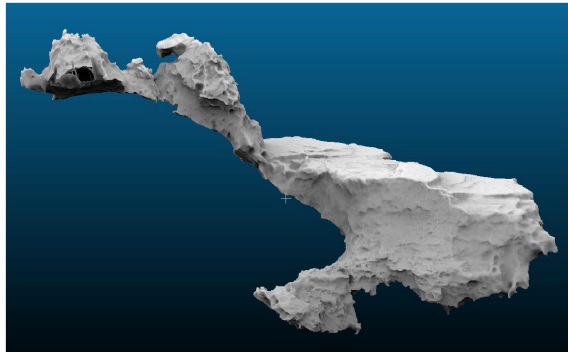
Figure 7. The final 3D mesh model, after cleaning and filtering.